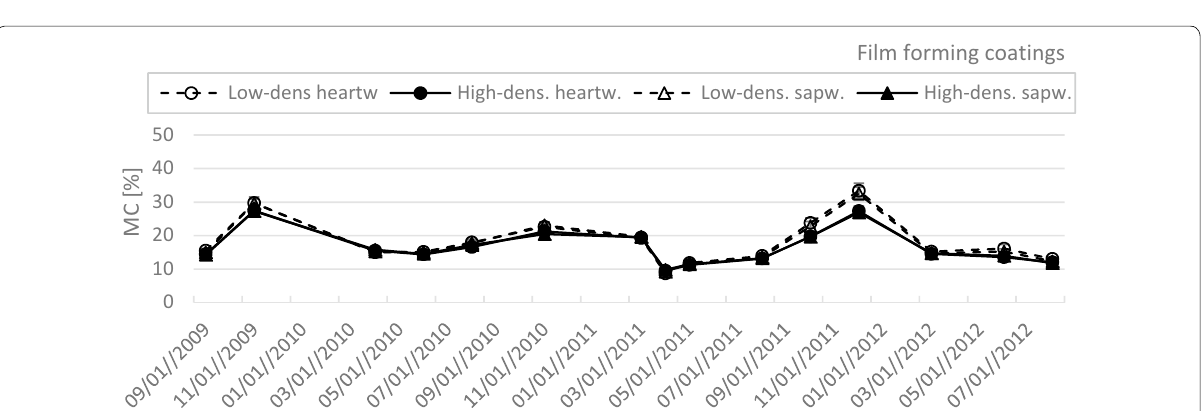
Fig. 3 MC fluctuation over 3 years for the film-forming coatings (average of A, B and C) categorised by high- or low-density heartwood or sapwood. The error bars represent the standard deviation of the values. The climate data during the period are given in Fig.